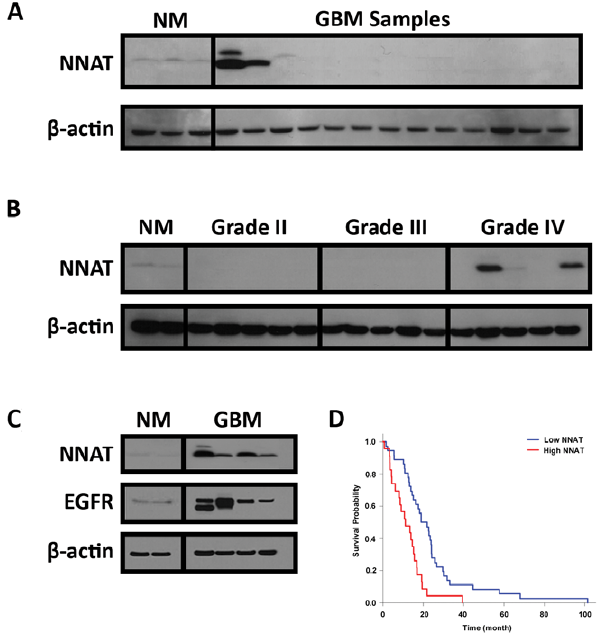
Figure 2. NNAT is Expressed in a Subset of Primary GBMs. (A) We initially surveyed 13 GBM samples for NNAT expression and found higher than baseline levels in 2 of the samples. (B) NNAT expression was not found in 10 WHO Grade II and III tumors, but was positive in an additional 5 GBM samples. A total of 23 GBM samples were assayed that overexpression of NNAT was found in 4 (17%) of the samples. (C) All tumors that expressed NNAT also had concurrent upregulation of the EGFR receptor, a feature that is associated with primary GBMs that arise